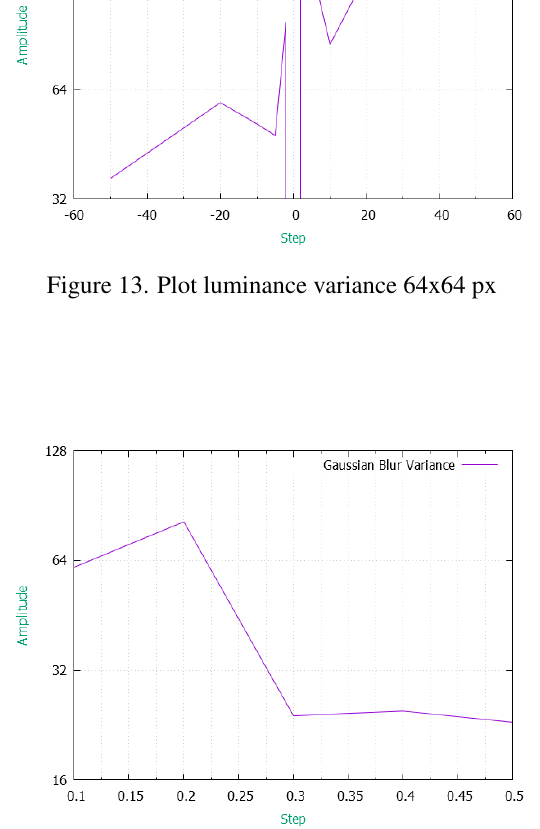
Figure 11. Plot Gaussian Blur mean 64x64 px